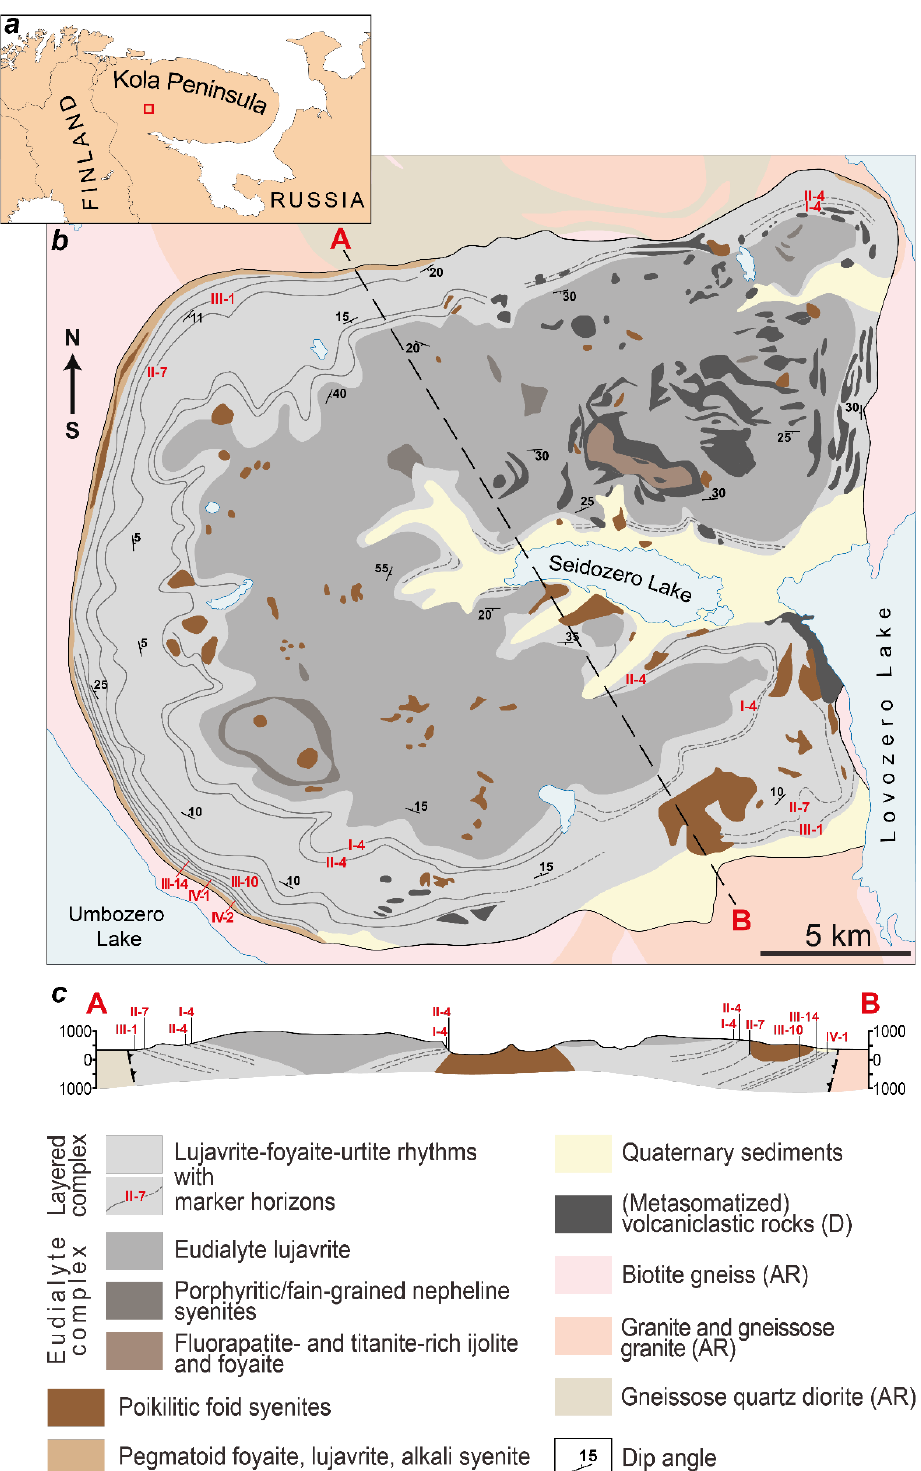
Figure 1. ( a ) location of the Lovozero massif within the Kola Peninsula (red square); ( b ) geological scheme of the Lovozero massif and ( c ) cross-section along the line A–B [30].